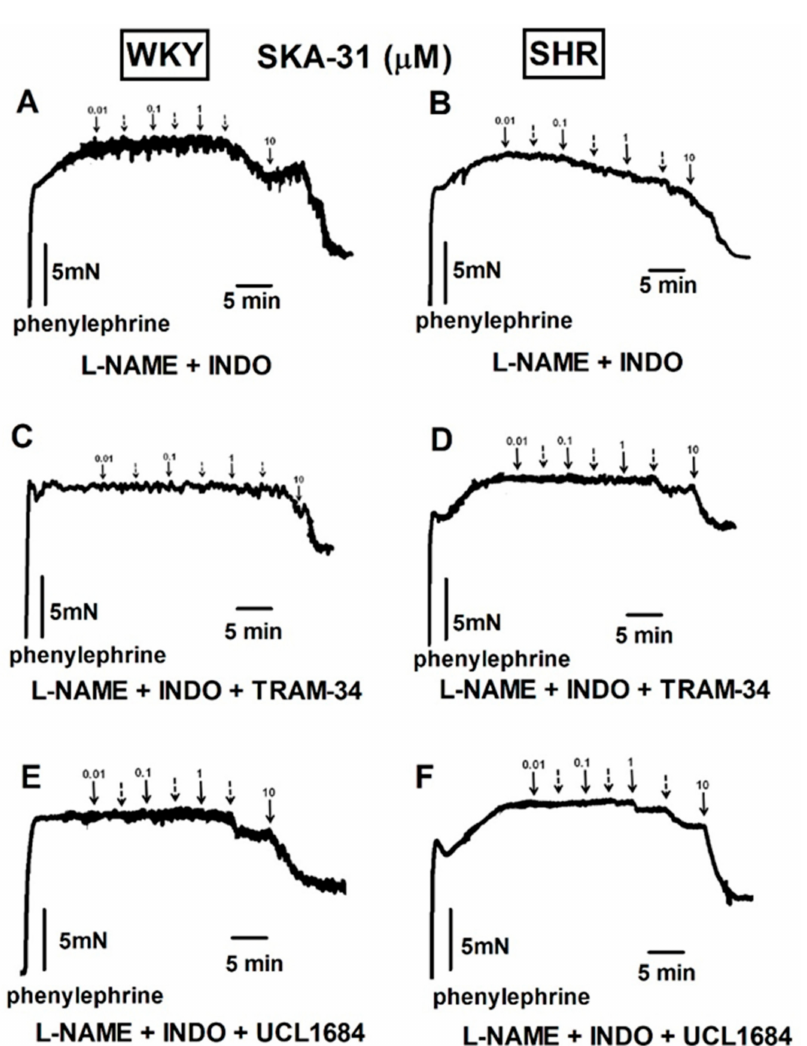
Figure 5. Traces from representative experiments showing the influence of indomethacin (INDO, 10 µ M) and NAME - l -arginine methyl ester ( l -NAME, 100 µ M) given together ( A , B ), TRAM-34 (10 µ M; C , D ) or UCL1684 (0.1 µ M; E , F ) given in the presence of l -NAME and INDO (100 µ M and 10 µ M, respectively) on the vasorelaxant e ff ect of SKA-31 in the small mesenteric arteries from normotensive WKY ( A , C , E ) and spontaneously hypertensive (SHR) rats ( B , D , F ). Arrows show the moment of application of the particular concentrations of SKA-31. Broken arrows represent the following concentrations (from the left): 0.03, 0.3, 3 µ M,